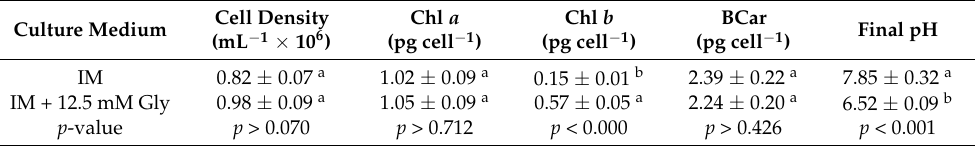
Table 3. Cell density, Chl a , Chl b , BCar, and culture pH of D . salina grown under 12.5 mM Gly and IM control. Isosmotic salinity for growth and light intensity were 3.0 M NaCl and 50 µ mol photons m − 2 s − 1 , respectively. The initial pH range was 6.20–6.35, and the final pH corresponds to the 7th day of cultivation. Values in the same columns with different superscript are significantly different.